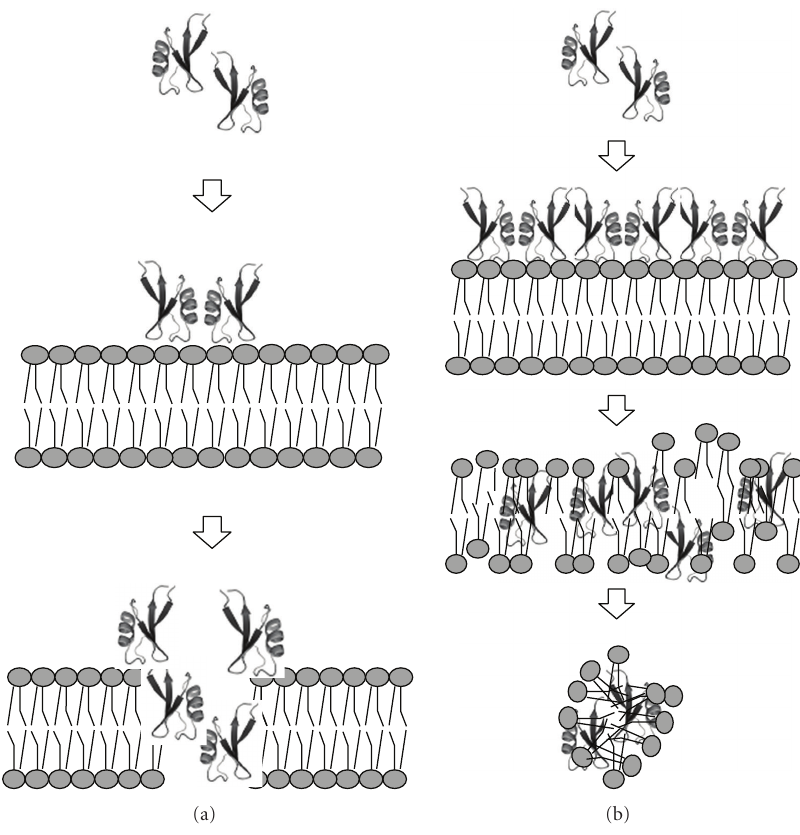
Figure 3: Scheme of the action mechanism for antibacterial peptides. (a) Barrel-stave model; (i) peptides in monomer or oligomer form come close to the membrane target; (ii) positively-charged residues from the peptides interact with the head group of the phospholipids from the membrane; (iii) at a threshold concentration of peptides, the pores are formed. In toroidal model, the major di ff erence is the type of pore formed, where lipids and peptides are overlapped. (b) Carpet model; (i) peptides in monomer or oligomers come close to the membrane target; (ii) hydrophilic regions of peptides are exposed to solvent and hydrophobic regions to membrane; (iii) at threshold concentration of peptides, the permeability of the membrane increases, facilitating pore formation; (iv) membrane disintegration. Adapted from Shai,